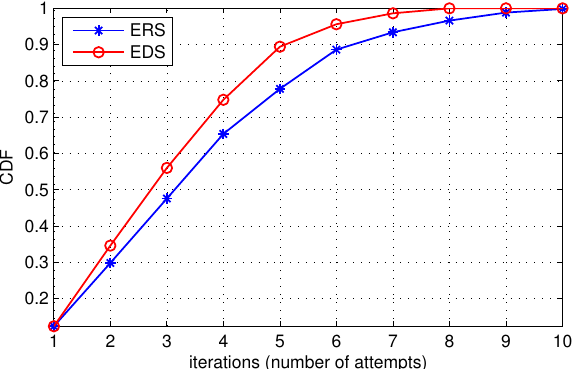
Figure 9. Probability to locate the